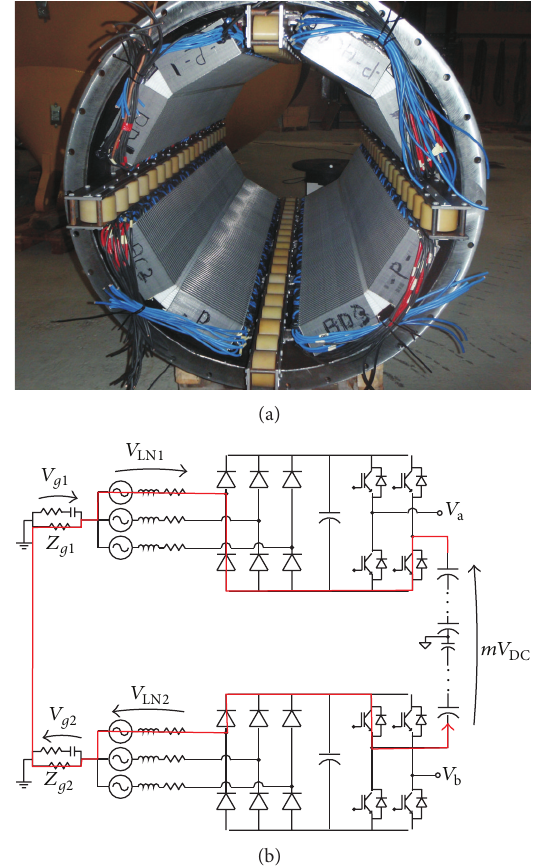
Figure 5: (a) Bottom view of the linear generator, where it can be seen how the stator windings are mounted against the hull. The hulls of the generators in the farm provide a low-impedance path to each other via the sea water. (b) The common ground path through the sea water via their grounding impedances, 𝑍 𝑔 , which are dominated by the cable insulation impedance of the stator windings. The red line illustrates one possible path for 𝑉 𝑔1 and 𝑉 𝑔2 to build up. The cable insulation must be rated above this to withstand an electrical